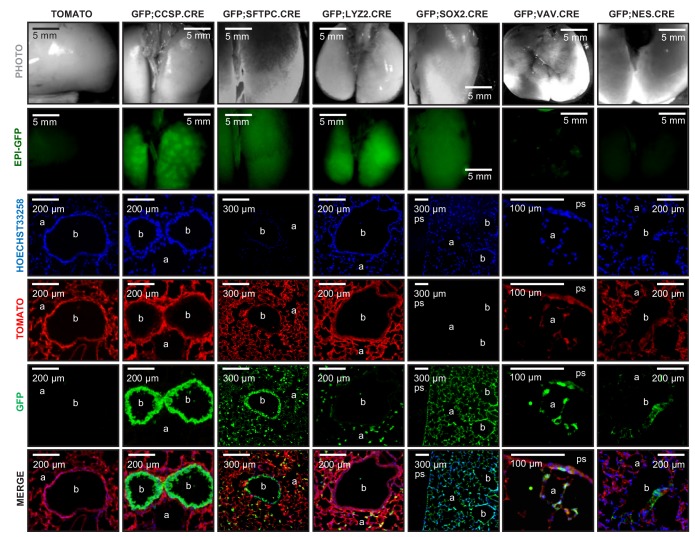
Genetic labeling of pulmonary lineages in seven lineage reporter strains on the C57BL/6 background: representative images.Representative photographs (top row) and green epifluorescence images (second row) of whole lungs, as well as fluorescent microscopic images of lung sections for nuclear Hoechst33258 stain (third row), endogenous TOMATO (fourth row), endogenous GFP (fifth row), and merged images (bottom row) of genetically marked mice on the C57BL/6 background employed in these studies (described in detail in Figure 1—figure supplement 2) at six postnatal weeks (n = 5/mouse strain). b, bronchi; a, alveoli; ps, pleural space.